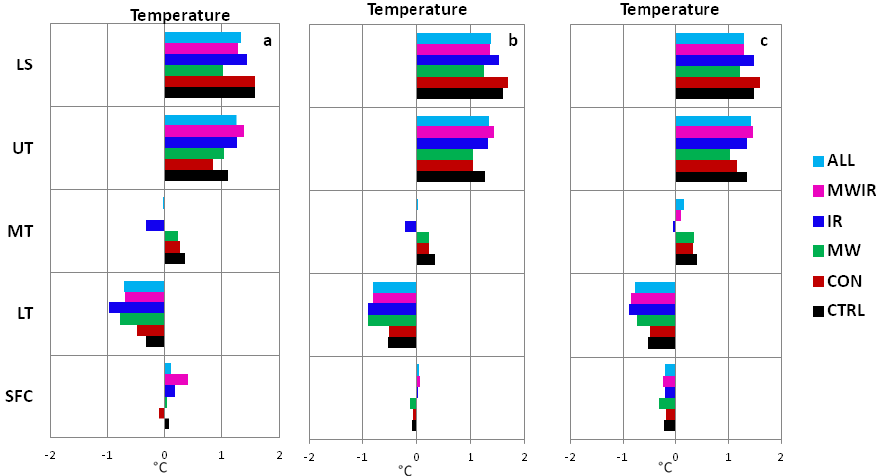
Figure 5. Bias profile of the temperature ( T ) forecasts at (a) 6h, (b) 30h, (c) 54h forecasts. Unit: ◦ C. Other definitions are the same as in Fig.